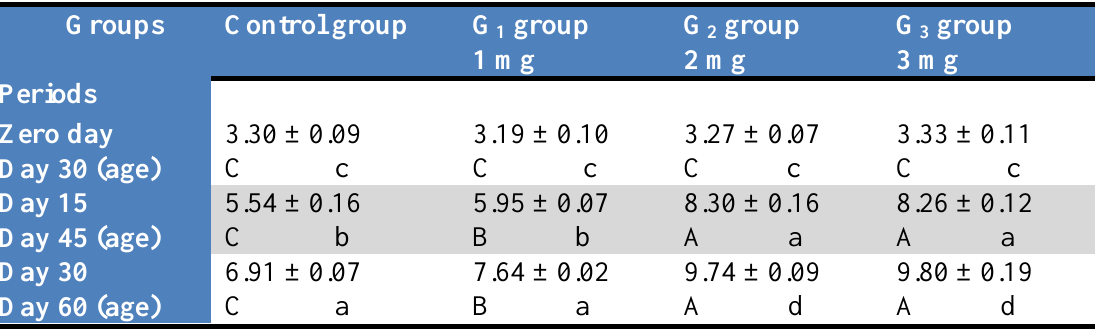
(Table: 1): Effect of different Doses of Estradiol Benzoate hormone on the body weight in Turkeys birds (M±